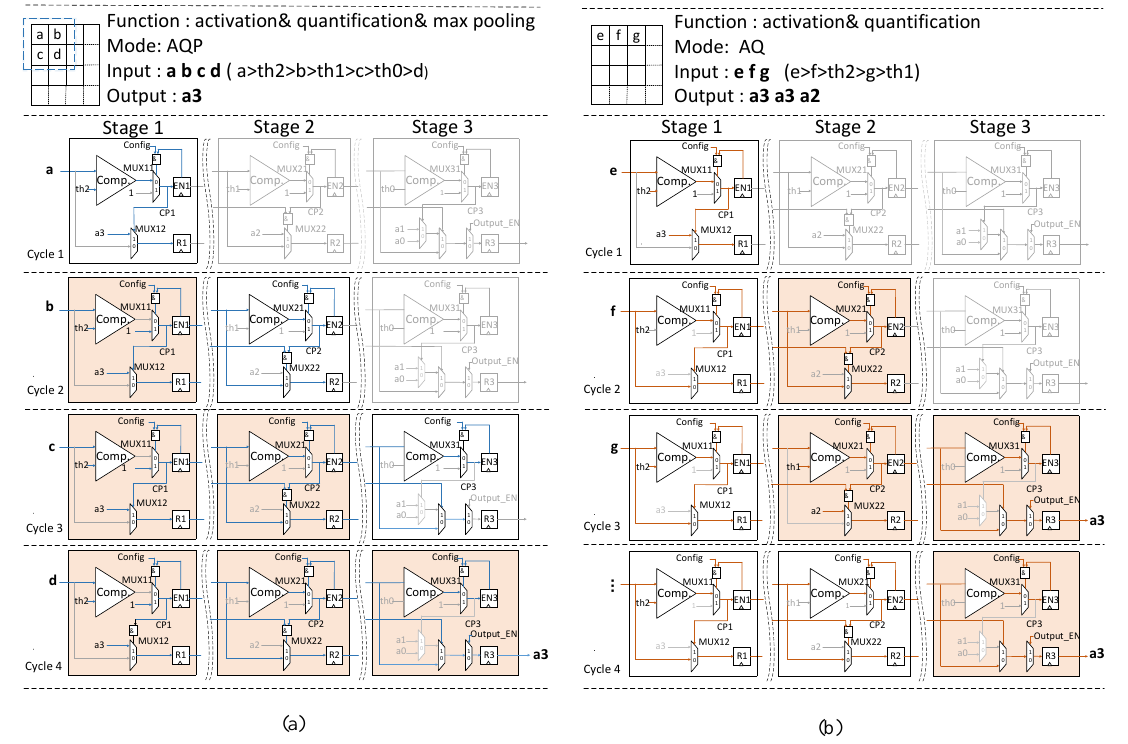
Figure 9. Processing details of ( a ) AQP mode, ( b ) AQ mode. The dark background indicates that the stage is